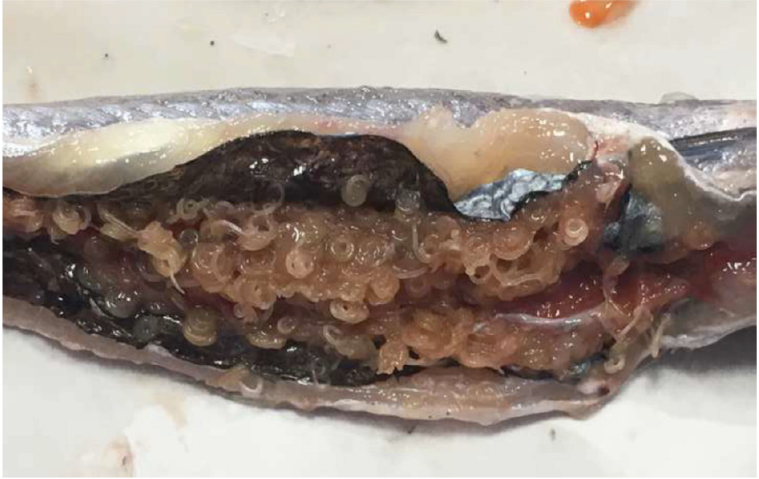
Figure 1. Massive infection of ascaridoid larvae in a blue whiting ( Micromesistius poutassou ). In the ungutted category, the prevalence of parasitization was 58%. Of these infected fish, massive infection was present in 47.4% ( n = 55), with the mean abundance in the other 61 being 2.9 ± 0.4. In the under-24-h subgroup (i.e., those examined within 24 h of purchase), 52.9% were infected. Of these, 39.7% ( n = 25) presented larvae in the muscle, mainly in the belly flaps. In the post-24-h subgroup, parasites were found in 65.4%, with 33 of these having parasites in the muscle.